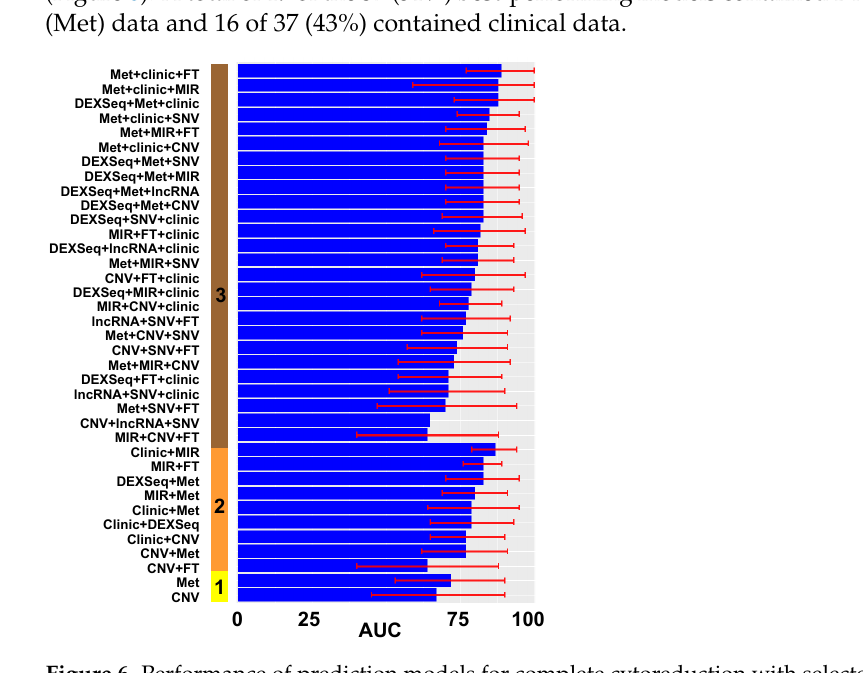
Figure 6. Performance of prediction models for complete cytoreduction with selected variables from best initial models. The solid vertical bar represents the number of types of data: 1 (yellow): only one variable was included in the model; 2 (orange): a combination of 2 types of variables; 3 types of variables: solid vertical line with 3 labels (maroon). Different performances are displayed in ascend ‐ ing order. The x axis is AUC as a percentage (0–100%). The red error mark displays the 95% confi ‐ dence interval (CI). We included all prediction models with a 95% CI of AUC that was included or was superior to 87%. Overall, 37 were selected (that had the potential to be superior to the clinical assessment). FT: fusion transcripts; Met: DNA methylation; SNV: single nucleotide variation; CNV: gene copy number; DEXSeq: exon expression; lncRNA: long non ‐ coding RNA; MIR: micro ‐ RNA, mRNA: gene expression. Graphics were generated with R package ggplot. The best ‐ performing models predicting optimal and complete cytoreduction were validated in a machine learning analytical platform using TensorFlow. All machine learn ‐ ing models, performed very well, with the AUC ranging from 89% to 100% (Supplemen ‐ tary Figures S7 and S8). 4. Discussion Optimal cytoreduction is consistently one of the strongest predictors of overall sur ‐ vival in the platinum ‐ based chemotherapy era [9–13,47]. There are several clinical factors known to affect the extent of surgical debulking, including surgical training and patient’s performance status [13,15]. In the present study, we also added biological or genomic fac ‐ tors that predicted cytoreduction accurately. Precise prediction of optimal surgical out ‐ comes with preoperative data has been an elusive objective, leading to suboptimal cytore ‐ duction in 20–30% of surgeries. Additionally, while neoadjuvant chemotherapy has been shown to be non ‐ inferior to primary debulking, there is evidence to indicate that: a) pa ‐ tients who undergo primary debulking with no residual disease may have improved sur ‐ vival and; b) those with residual disease ≤ 1 cm may have equivalent survival compared to patients who receive neoadjuvant chemotherapy and have no residual disease at the completion of their surgery [48]. Given this information, it is imperative to identify those patients who can be successfully cytoreduced and triage them to primary cytoreductive surgery, if they are fit for the planned procedure.